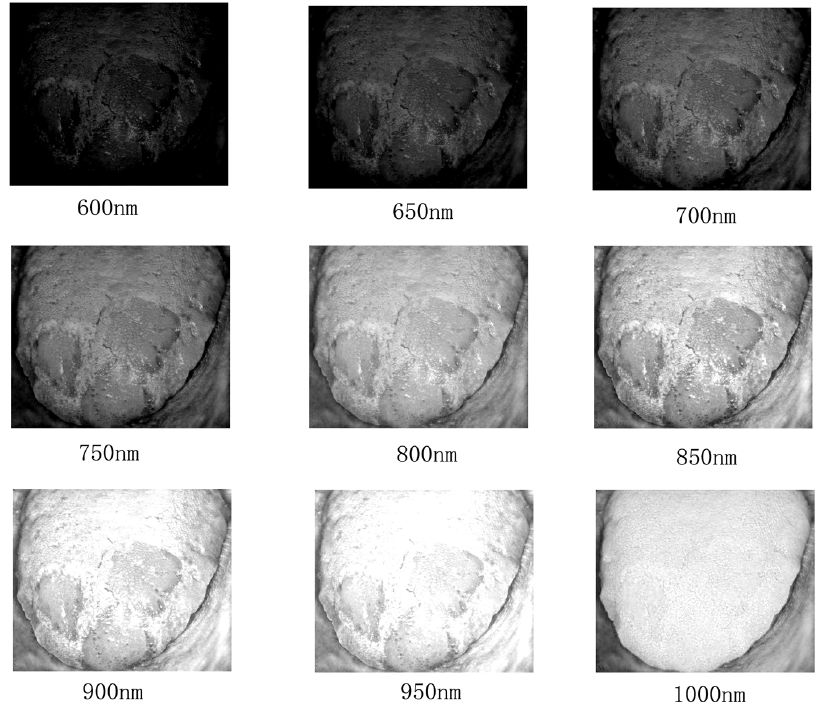
Figure 4. Some examples of tongue tumor hyperspectral